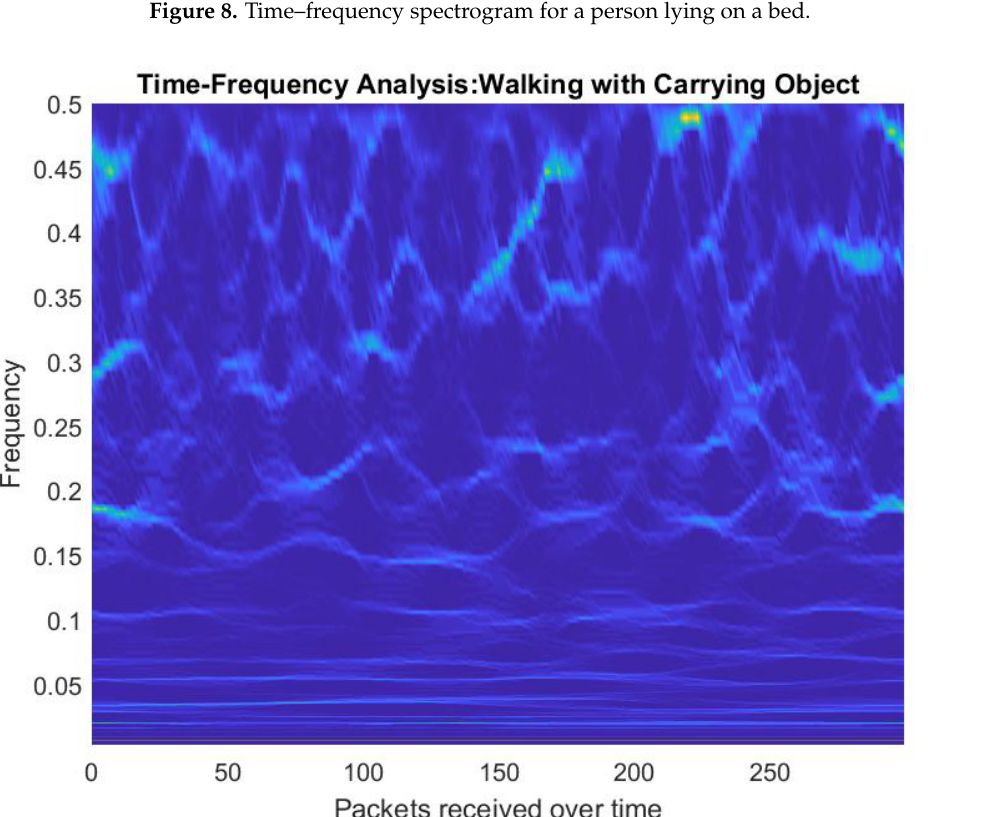
Figure 9. Time–frequency spectrogram for a person walking while carrying an